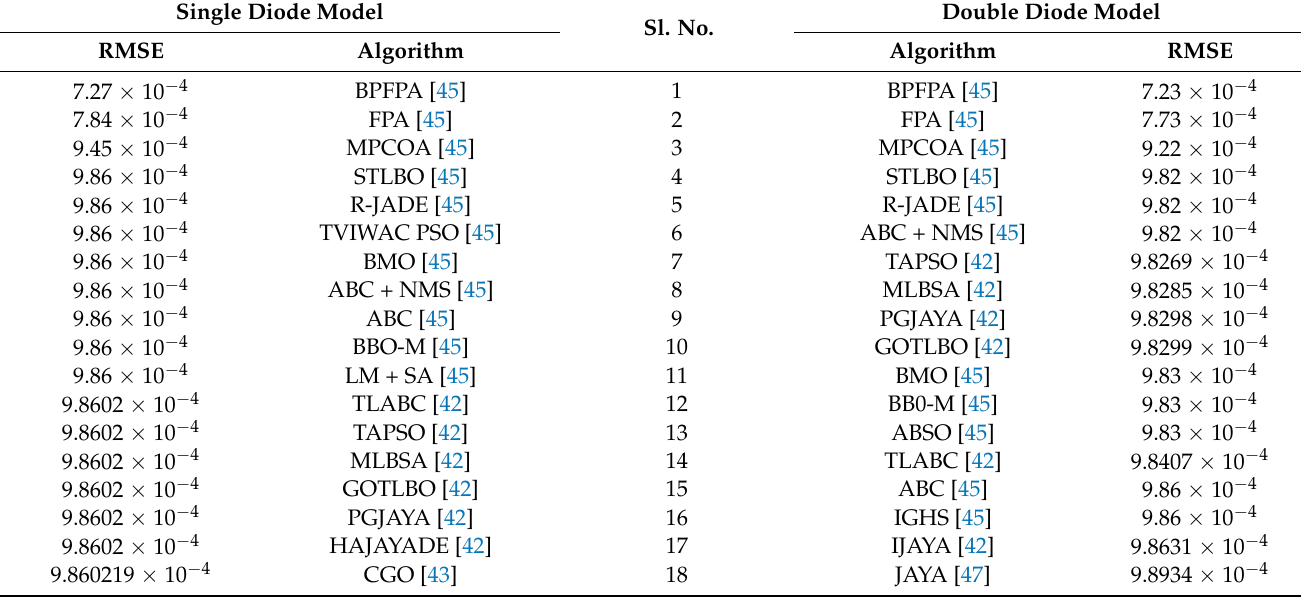
Table 5. Performance comparison of the parameter identification models for the 57 mm dia RTC France solar cell